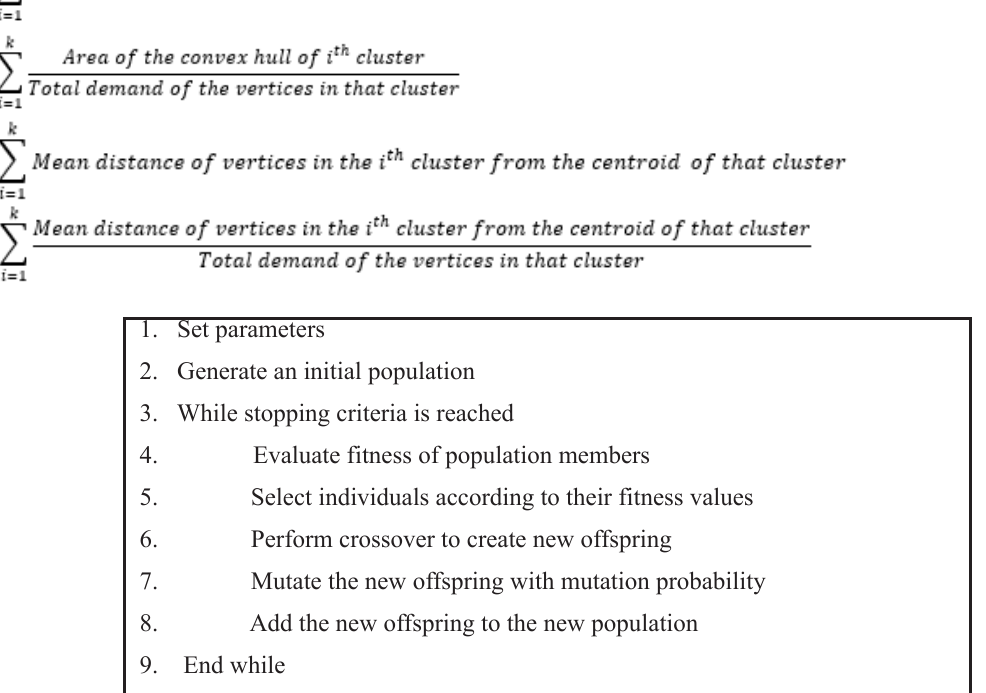
Figure 1: The pseudocode of the standard GA.